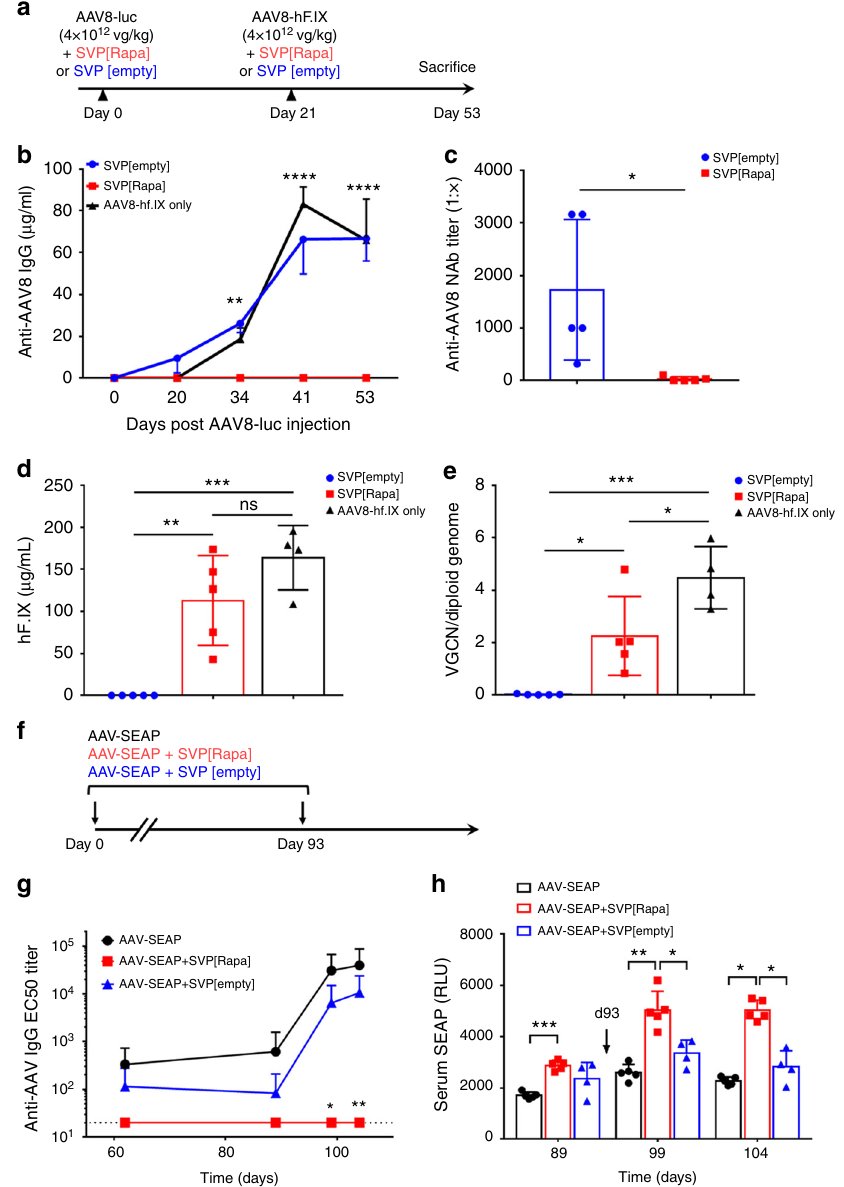
Fig. 1 SVP[Rapa] treatment prevents anti-AAV capsid antibody responses in mice. a Protocol outline. Male C57BL/6 mice ( n = 5 per group) were treated intravenously with 4 × 10 12 vg kg − 1 of AAV8-luc together with SVP[Rapa] (200 µ g) or with SVP[empty] control. Three weeks later, animals were challenged with 4 × 10 12 vg kg − 1 of AAV8-hF.IX vector mixed with either SVP[Rapa] (200 µ g) or SVP[empty] control. One additional control group ( n = 5) of naive animals received 4 × 10 12 vg kg − 1 of AAV8-hF.IX vector alone at day 21 (de fi ned as “ AAV8-hF.IX only ” ). b Analysis of anti-AAV8 IgG antibodies measured by ELISA (** p < 0.01, **** p < 0.0001, refers to the signi fi cance between SVP[Rapa] and SVP[empty] or AAV8-hF.IX groups). c Anti-AAV8 neutralizing antibodies (NAbs) titers on day 54. d hF.IX antigen levels in plasma on day 54 determined by ELISA. e AAV8 vector genome copy number (VGCN) per diploid genome performed after killing (day 53). f Protocol outline. Three groups of C57BL/6 male mice ( n = 5 per group) were prime-boosted (days 0 and 93, arrows) with 5 × 10 11 vg kg − 1 of AAV8-SEAP alone, or AAV8-SEAP mixed with SVP[Rapa] (50 µ g), or AAV8-SEAP mixed with SVP [Empty] control. g Anti-AAV8 IgG antibodies measured by ELISA (* p < 0.05, ** p < 0.01, refers to signi fi cance between SVP[Rapa] and AAV-SEAP). h Expressed SEAP activity in serum. Data are shown as mean ± s.d. Statistical analyses were performed by two-way ANOVA with Tukey post hoc test in b , g , and h , and by unpaired, two-tail t -test in c and by one-way ANOVA with Tukey post hoc test in d and e (* p < 0.05, ** p < 0.01, *** p < 0.001, **** p < 0.0001; ns not signi fi